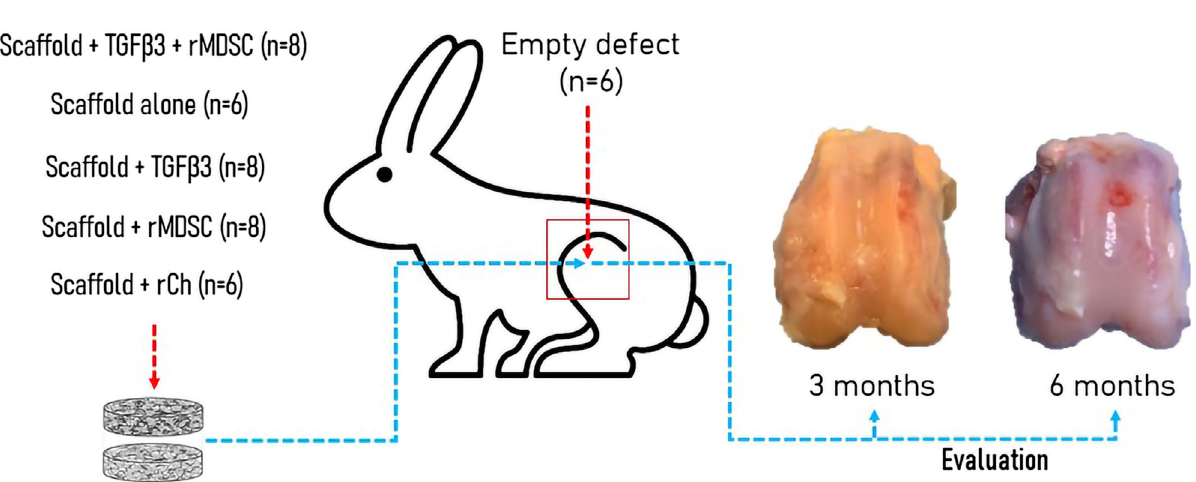
FIGURE 1 Experimental in vivo rabbit model. Different groups were formed according to the type of implant into the cartilage defect. Evaluation of cartilage repair including macroscopic, electromechanical, and histological analyses was performed after 3 and 6 months. TGF β 3,